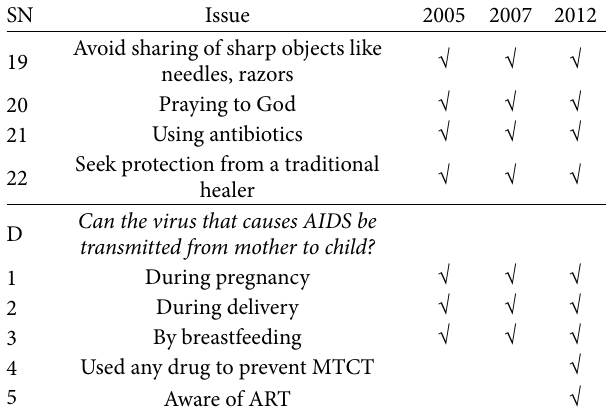
Table 1: List of questions used to compute the knowledge of STI and HIV transmission and